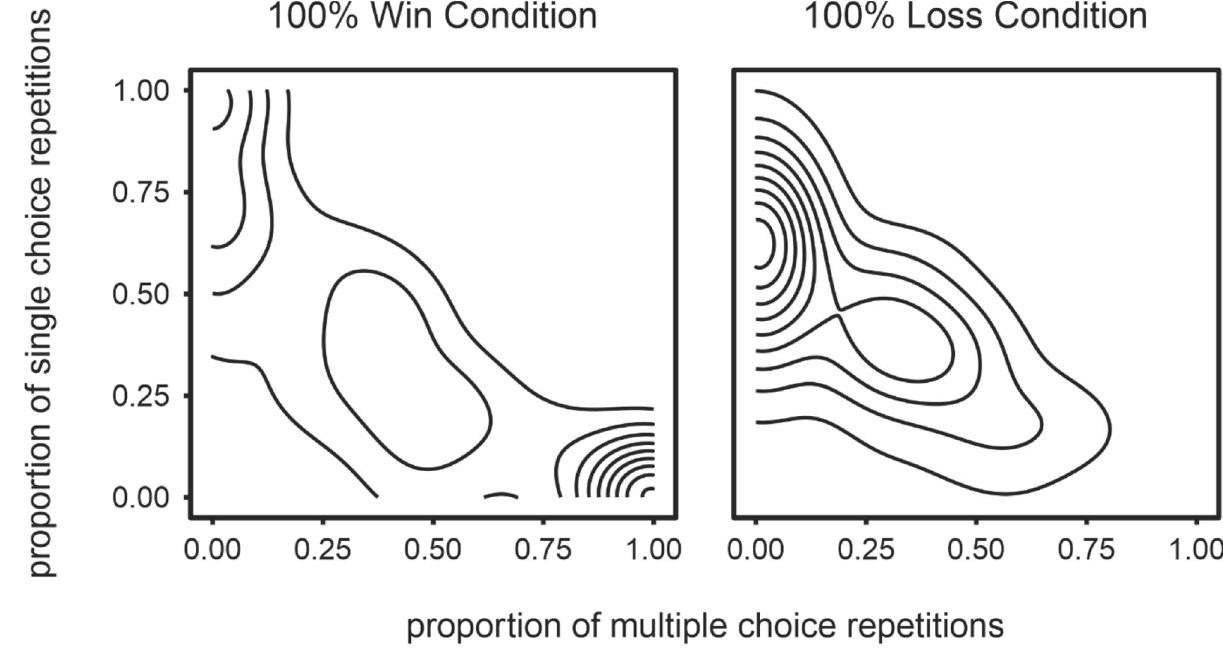
FIGURE 3 | Density plots representing exploration of strategy space in the 100% win (left panel) and 100% loss (right panel) conditions. The proportion of trials on which play involved complex strategies (alternations and sequences) are presented on the x-axis and the proportion of trials where a single choice was played repeatedly is presented on the y-axis. The density plot was generated by collapsing across all participants, for each condition separately. Regions with many concentric lines indicate a high density or frequency of that particular distribution of